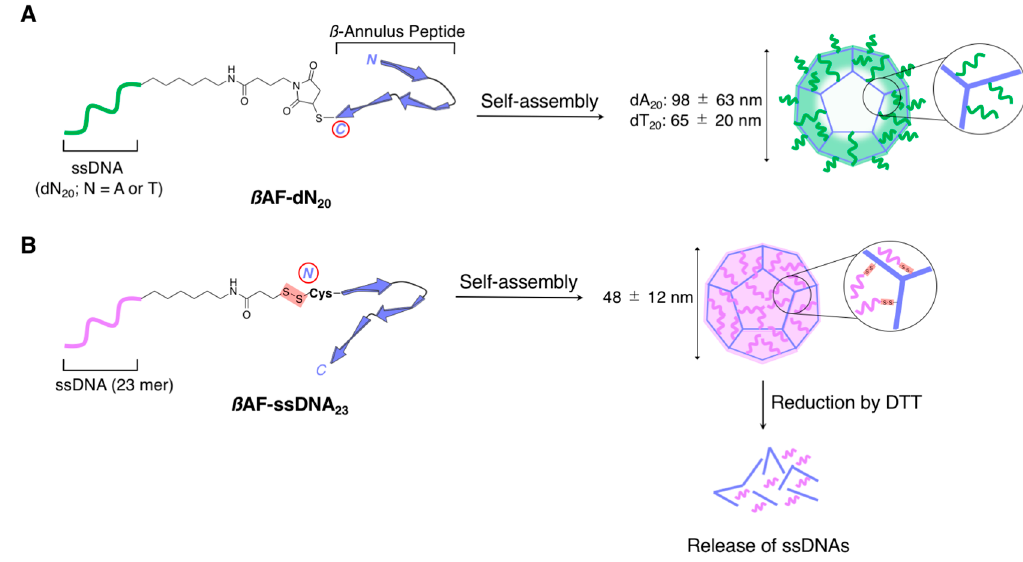
Figure 11. ( A ) Schematic representation of the self-assembly of β -annulus fragment ( β AF )_dN 20 [N = A ( β AF_dA 20 ) or T ( β AF_dT 20 )] to form spherical capsular architectures that displayed the nucleic acids at their exterior surfaces. ( B ) Schematic representation of the self-assembly of β AF_ssDNA 23 to form spherical capsular architectures that encapsulated the nucleic acids. Adapted from ref 88. Copyright 2017 John Wiley and Sons Publisher. Adapted from [95]. Copyright 2019 the Chemical Society of Japan.